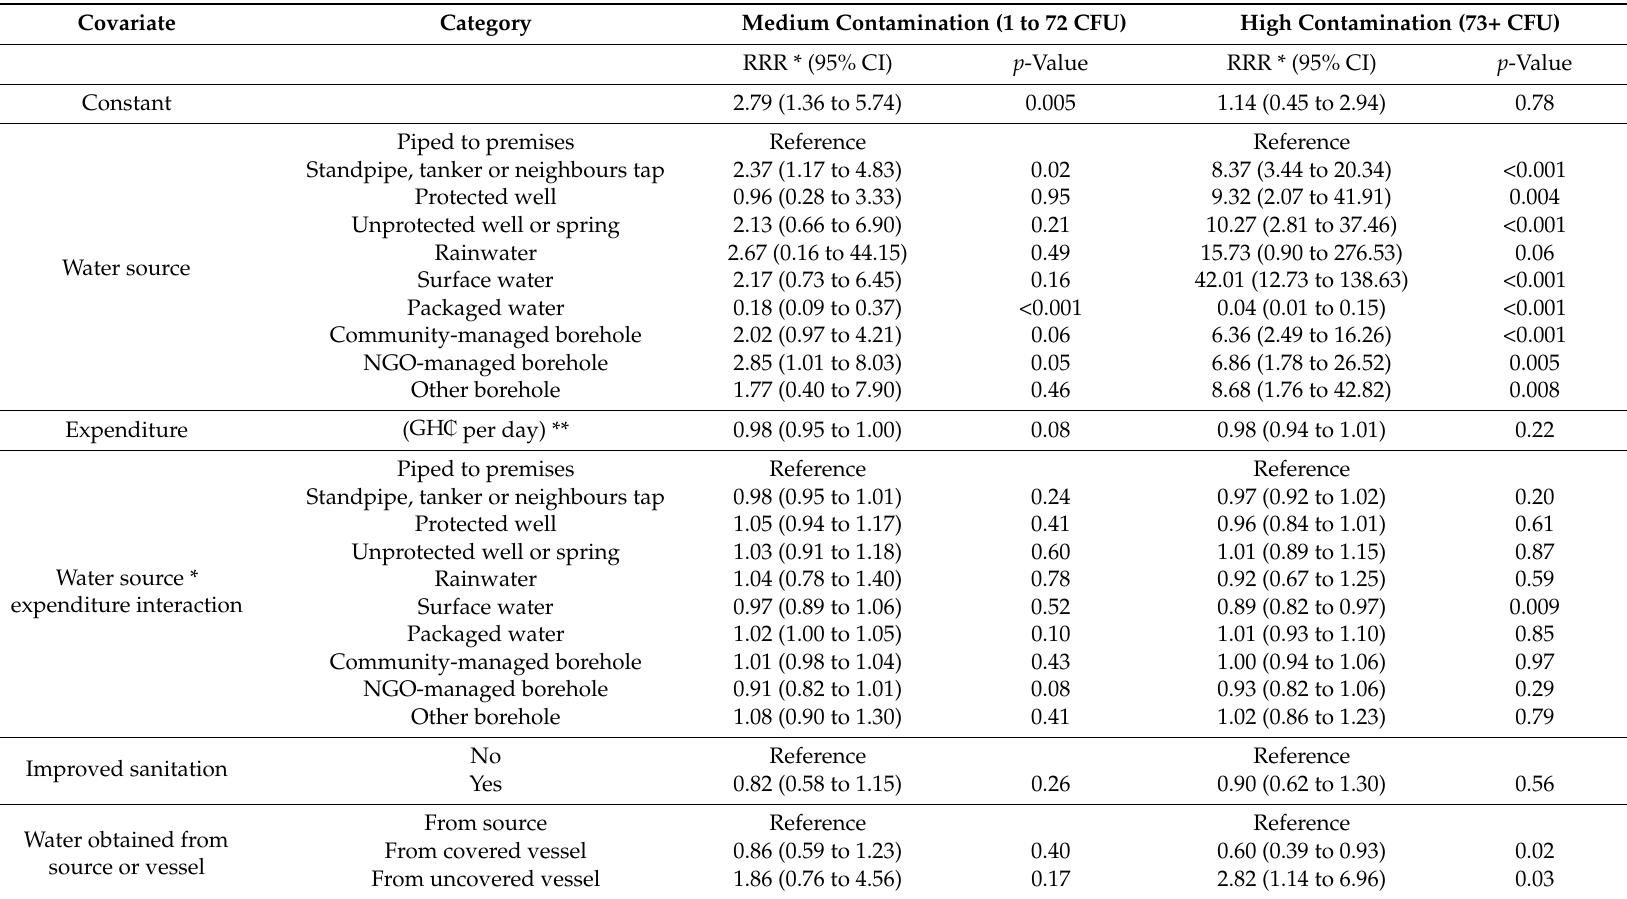
Table 3. Relative risk ratios for medium (1 to 72 cfu/100 mL) and high (>72 cfu/100 mL) contamination of point-of-consumption drinking water with E. coli derived from multivariable multinomial regression